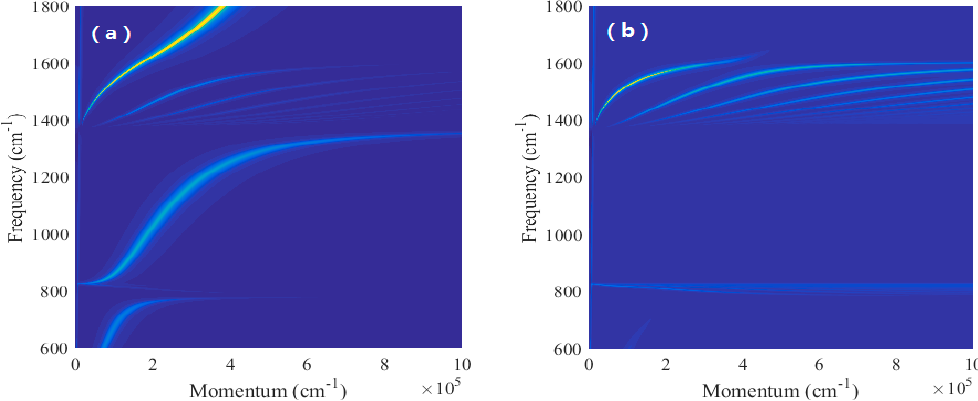
Figure 7. The effect of different excitation orders on transmission properties. ( a ) SPPs excited first and ( b ) HPPs excited first. Here, the Fermi energy of graphene and the thickness of the h-BN slab are 0.8 eV and 100 nm, respectively.